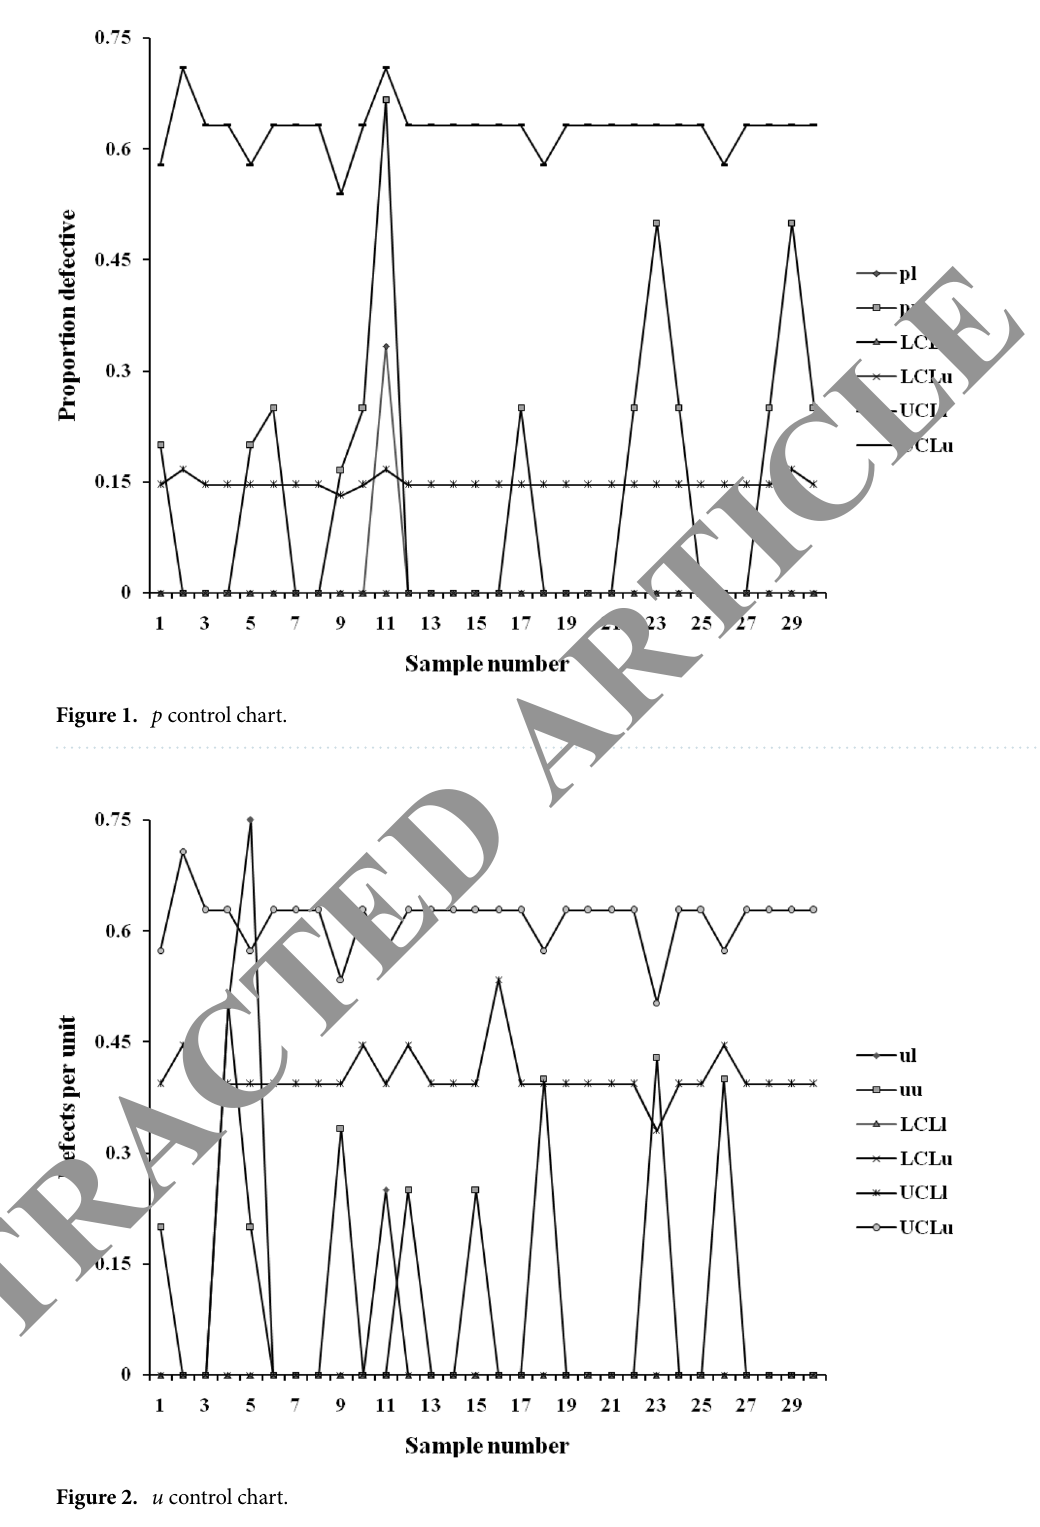
Figure 2. u control